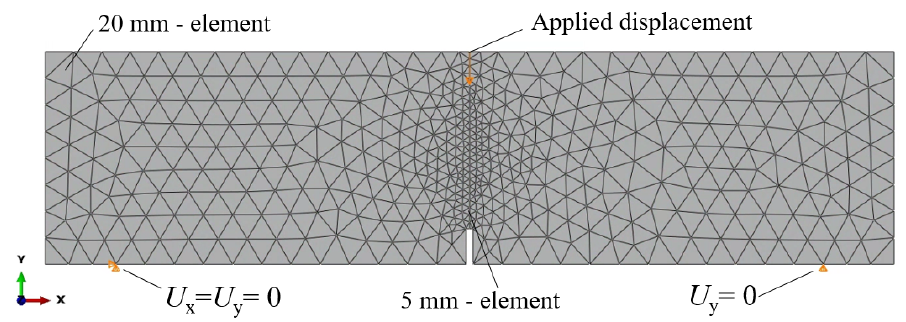
Figure 7. 2D FEM model adopted: mesh and boundary conditions considered.